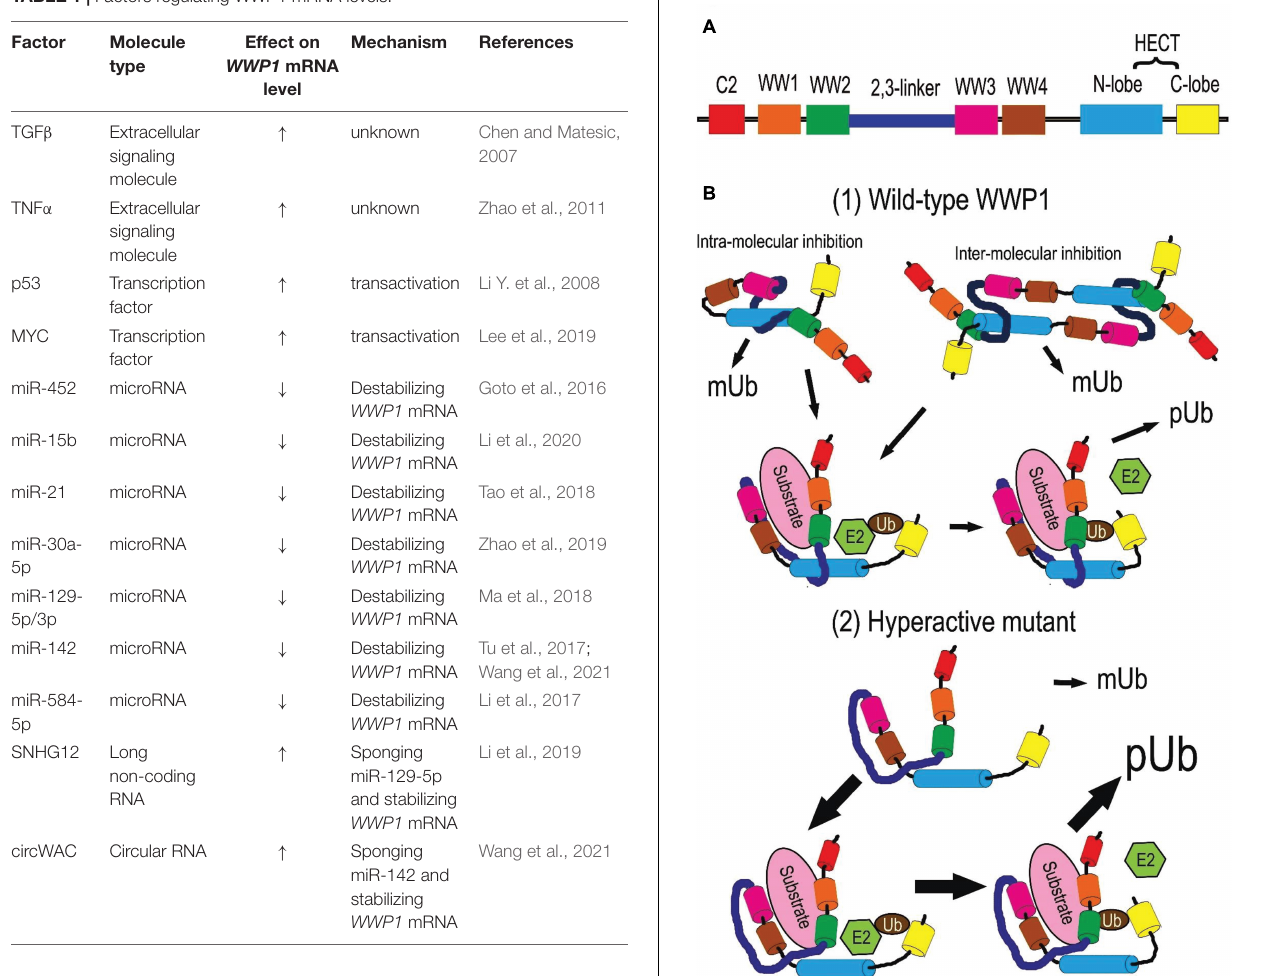
TABLE 1 | Factors regulating WWP1 mRNA levels.